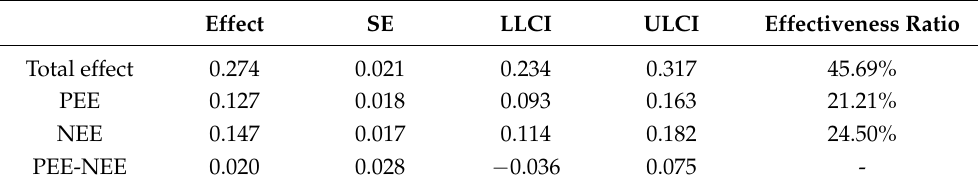
Table 8. Regressions testing EE as a mediator in the relationship between EC and